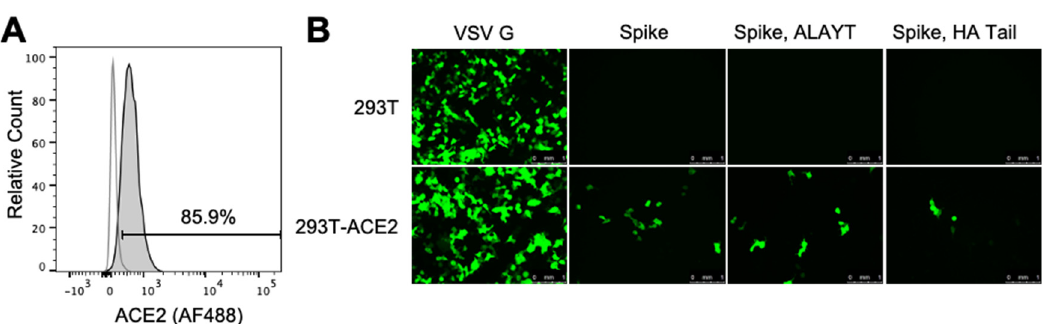
Figure 2. 293T-ACE2 cells are infectable with SARS-CoV-2 Spike-pseudotyped lentiviral particles. ( A ) Flow cytometry plot showing expression of human ACE2 by the 293T-ACE2 cells (grey shaded) at passage 12 compared to parental 293T cells (white fill) as quantified by staining with an anti-ACE2 antibody (see Section 4.2 for detailed methods). The gate was set so the parental 293T cells were 2% positive. ( B ) Microscope images showing ZsGreen expression in 293T-ACE2 or 293T cells at 58 h after incubation with Spike- or VSV G-pseudotyped lentiviral particles with the ZsGreen backbone. For each viral entry protein, 293T and 293T-ACE2 cells were incubated with equal volumes of virus. Cells were incubated with 1 / 20 th the volume of VSV G-pseudotyped lentivirus compared to Spike-pseudotyped lentivirus. The decrease in infected cells for the Spike-HAtail virus compared to the other Spike-pseudotyped lentiviruses is consistent with this virus having somewhat lower titers (see Figure 3A).